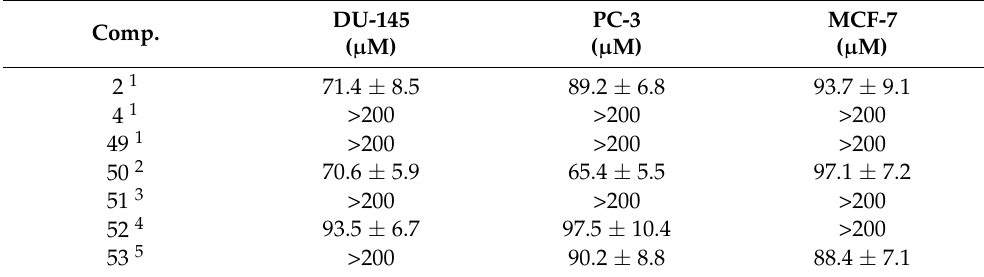
Table 2. Cytotoxicity of drimanes from Montenegro et al.; IC 50 values against DU-145, PC-, and MCF-7 cancer cells are given [64]